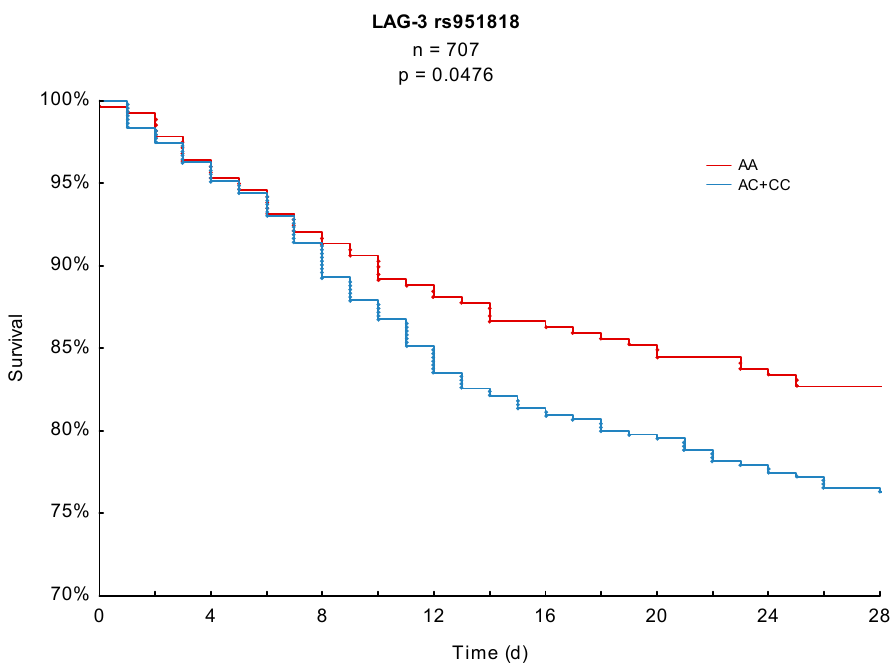
Figure 1. Kaplan–Meier 28 ‐ day survival analysis with respect to the LAG ‐ 3 rs951818 SNP.